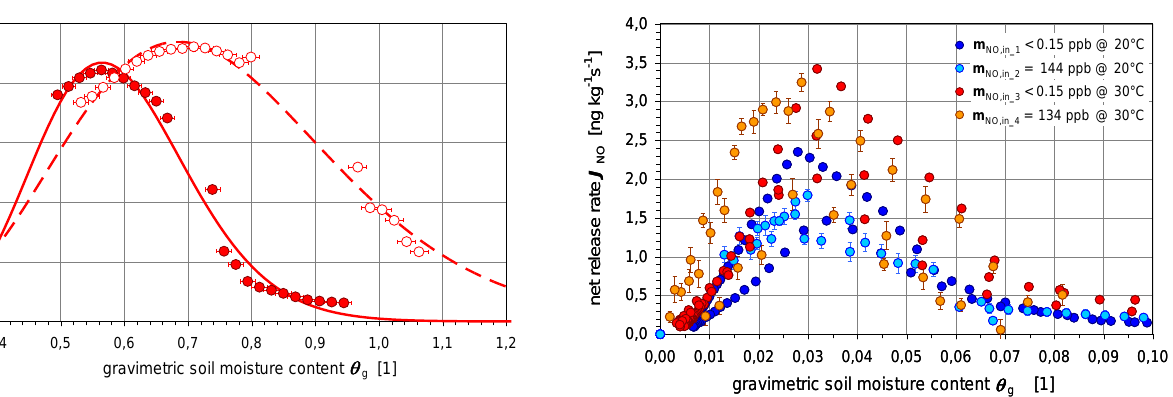
Figure 6. Results of individual NO net release rate ( J NO ) measure- ments performed on 12 sub-samples of a desert soil from Mongolia; Fig. 6: Results of individual NO net release rate ( J NO ) measurements performed on 12 three replicates have been measured for each of the four measure- sub-samples of a desert soil from Mongolia; three replicates have been ment conditions indicated by the four different colours of shown measured for each of the four measurement conditions indicated by the four data different colors of shown data points.